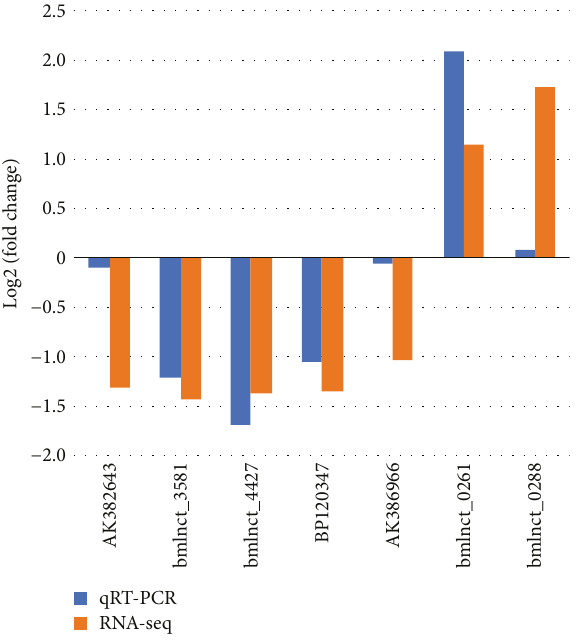
Figure 6: Real-time quantitative PCR results of